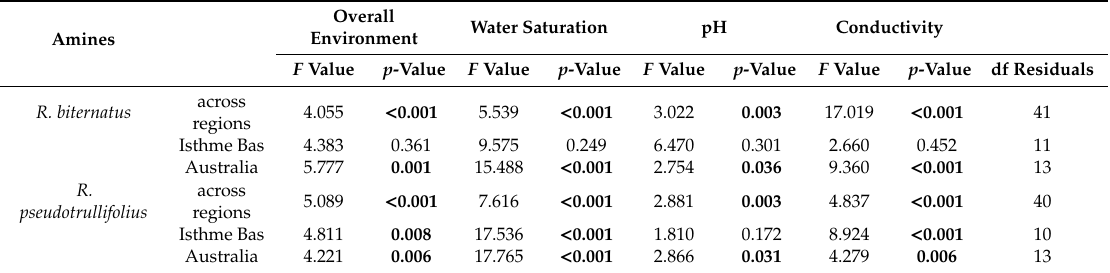
Table 3. Multivariate relationship between a given environmental variable and compositions of either all amines or all quercetins. Multivariate multiple regression analysis relating a given environmental variable to levels of all compounds